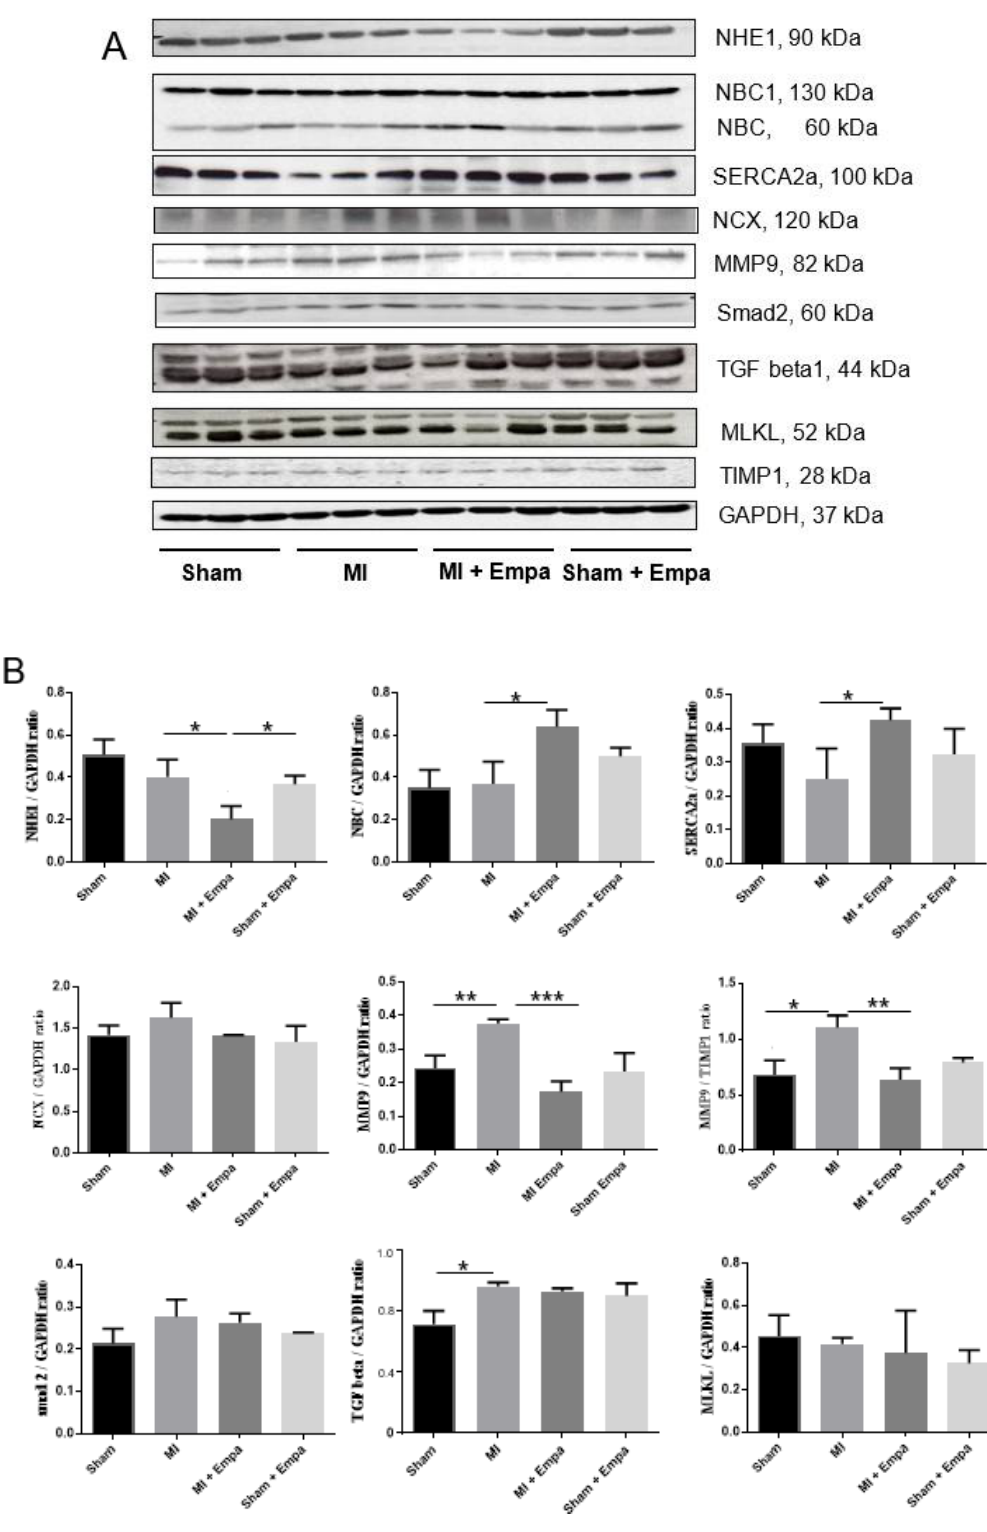
Figure 3. Molecular biological analysis of left ventricular 7 days after myocardial infarction. Western blot analysis of cardiac transporters (NHE1, NBC, NCX, SERCA2a), matrix metalloprotease 9 (MMP9), markers of fibrosis (smad, TGF- β 1), marker of necroptosis (MLKL). ( A ) Representative Western blots: sham operation, MI vehicle, MI treated with Empa, sham operation treated with Empa. ( B ) Densitometric data of proteins are mean ± SEM (bars); * P < 0.05; ** P < 0.01; *** P < 0.001; two-tailed unpaired t